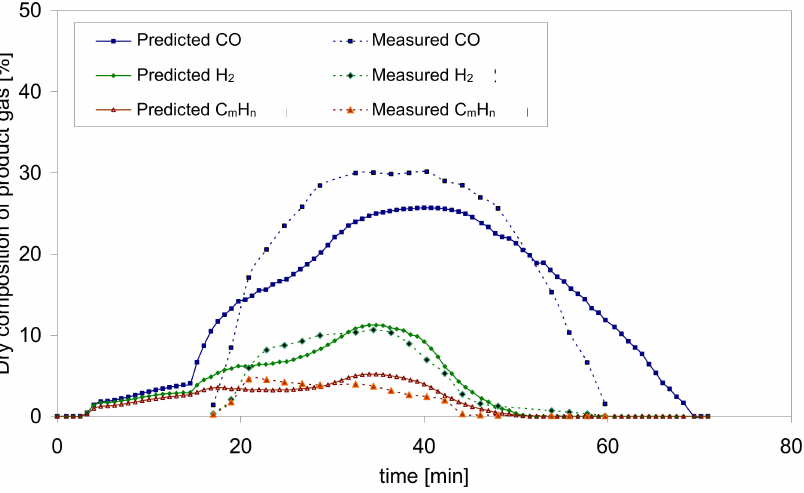
Figure 9. Comparison of the obtained results of numerical calculations and experimental tests in the case of feeding with an oxidizer at a temperature of 350 ◦ C, volumetric flow rate of 50 Nm 3 /h, diameter 12 mm and 20 kg pellets weight,